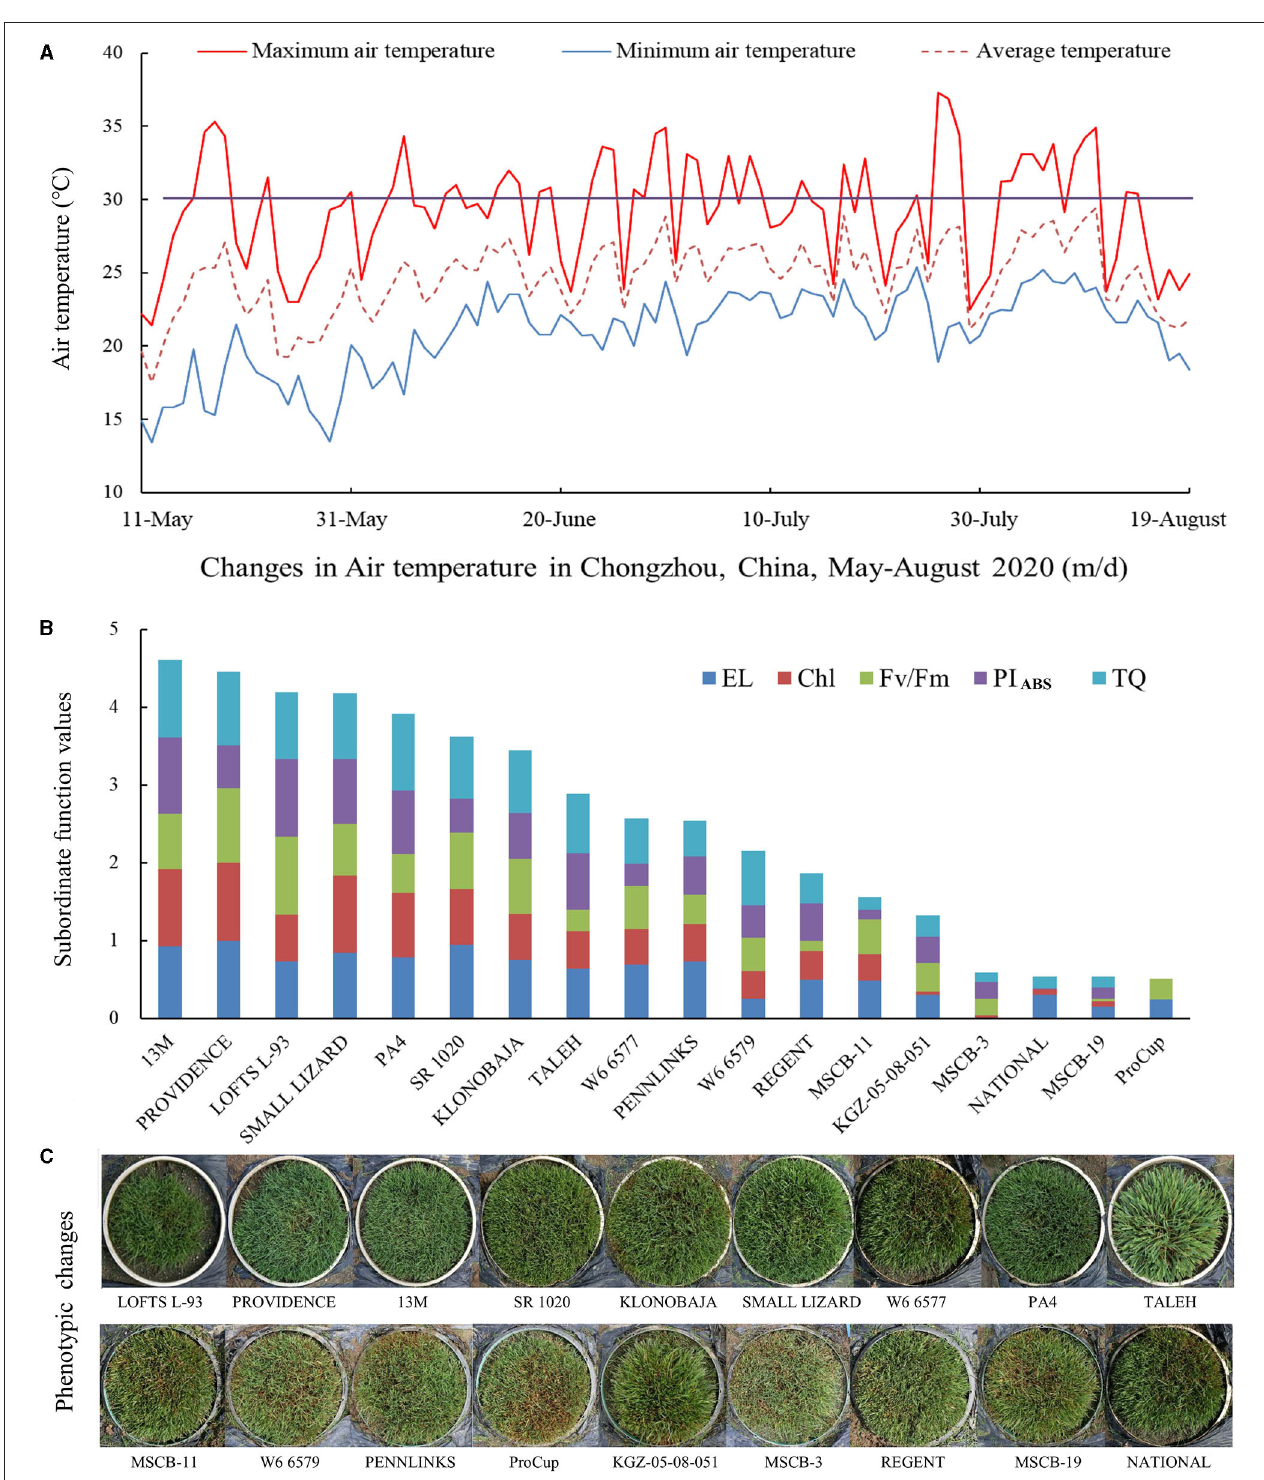
FIGURE 2 | Changes in (A) daily maximum, minimum, and average air temperature, (B) the subordinate function values analysis of five different physiological parameters for comprehensive evaluation of heat tolerance, and (C) phenotypes of 18 creeping bentgrass materials during summer in 2020 under field conditions.